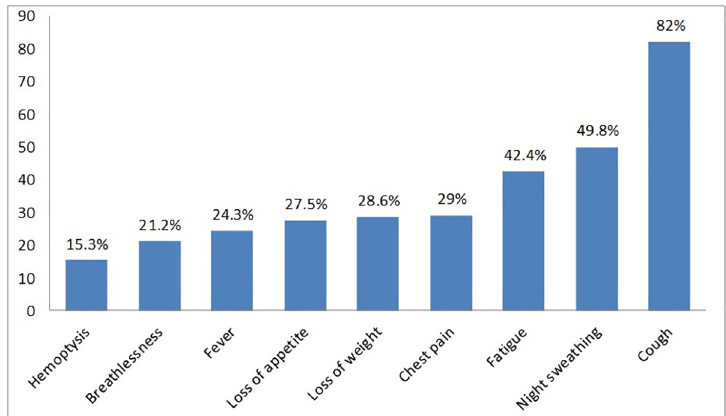
Fig 2. Complaints, which made patients, seek medical care in Gamo zone public health facilities, Southern Ethiopia, 2019.